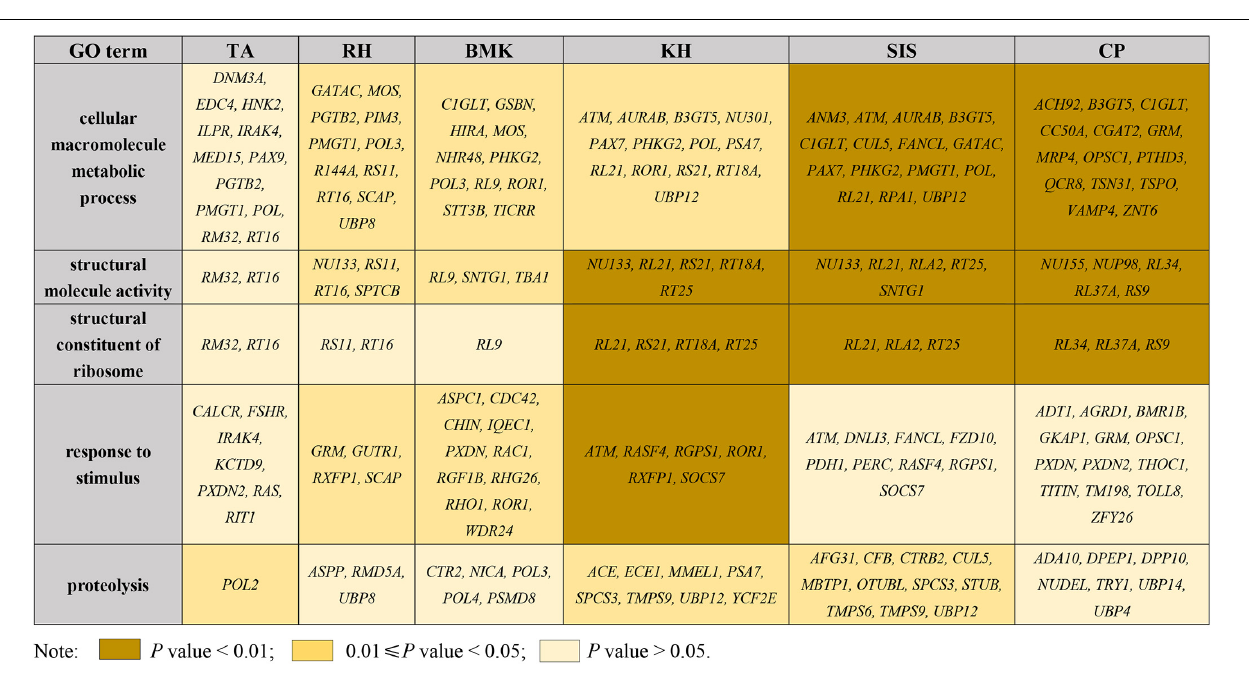
FIGURE 4 | Shared enriched GO terms of selective genes among each